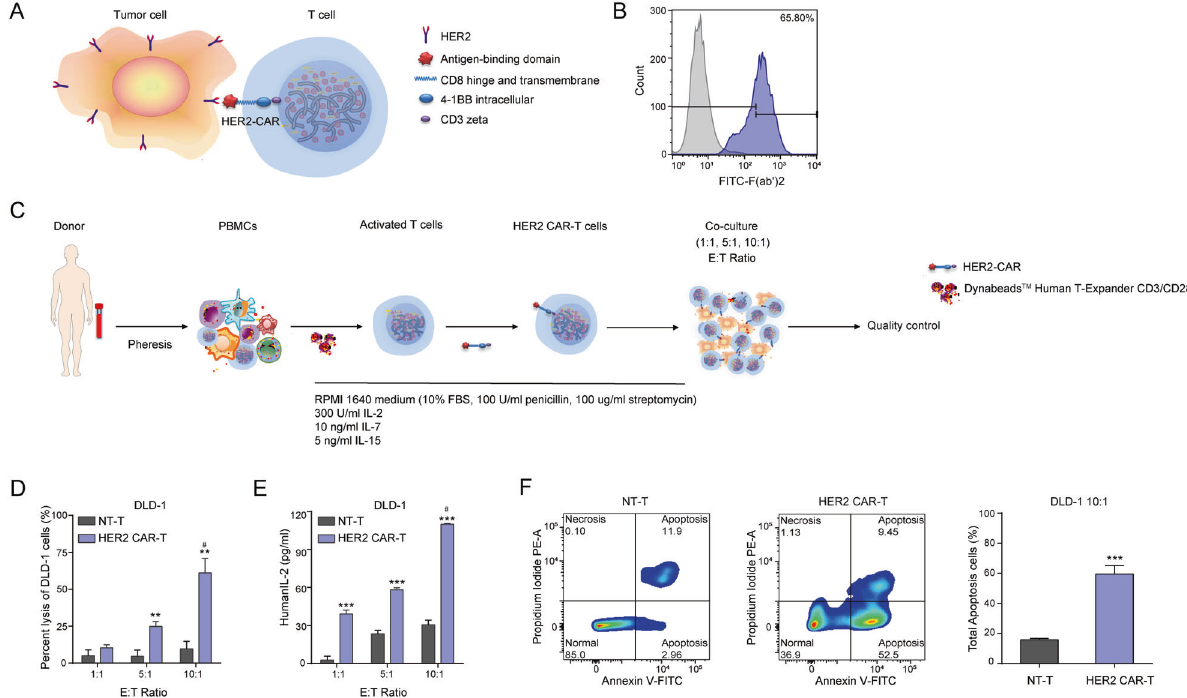
Fig. 3 Construction of HER2 CAR-T cells that can speci fi cally target CRC cells. A Structure and mechanism of action of HER2 CAR-T. B Surface expression of the HER2-CAR on lentivirus infected T cells was detected by fl ow cytometry on 10th day after lentivirus infection. C Procedure of allogeneic HER2 CAR-T therapy. D , E Cytotoxicity assays and cytokine release assays (* P < 0.05, ** P < 0. 01, *** P < 0. 001, compared with NT-T of each sub-group, two-tailed t -test; # P < 0.05, compared with 1:1 of each sub-group, Kruskal – Wallis test followed by the Dunn ’ s multiple comparison test). F An apoptosis kit was conducted in the co-culture model at the E/T ratio of 10:1, and the representative images of cell apoptosis are shown (*** P < 0.001, compared with NT-T, two-tailed t